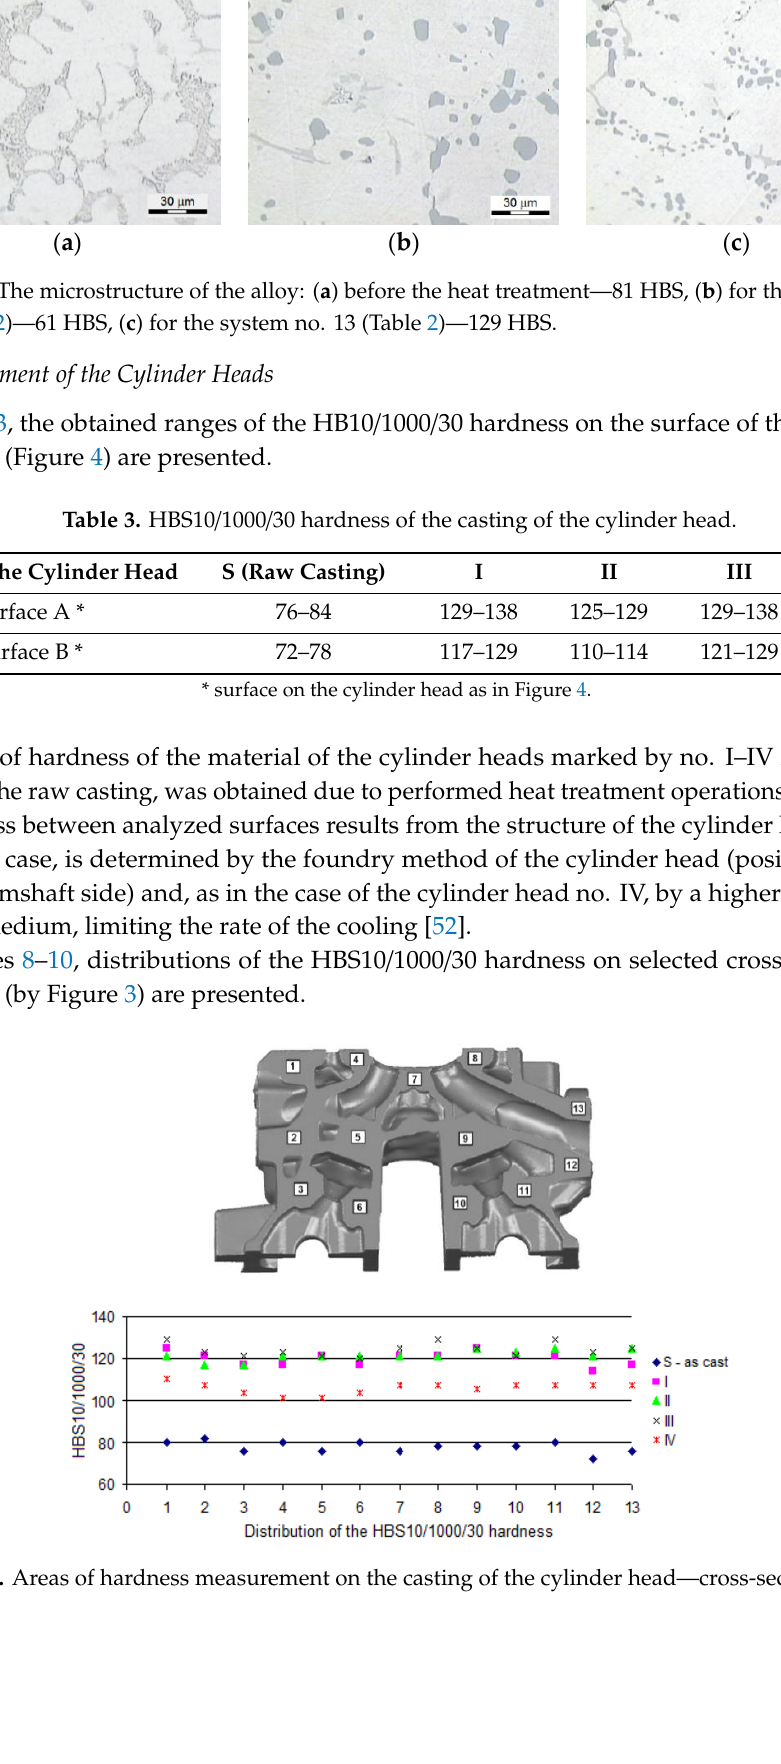
( b ) Figure 6. Influence of the heat treatment parameters on the hardness of the alloy. ( a ) t s and t a , ( b ) τ s and τ a. Taking into account obtained results of the measurements of the molded test pieces, it was ascertained that to obtain a considerable increase in the hardness, the alloy should be solutioned for 1–2 h at a temperature between 500–515 °C and aged for 2–5 h at a temperature below 180 °C (which should result in obtained HBS10/1000/60 hardness at the level of 120–130 (increase at the level of 50%)). Such hardness for the alloy of 319 brands with Mg additive (with a chemical composition similar to the investigated one) was obtained by the authors of the study [32] after solutioning at temperature 495 °C for 8 h and aging at temperature 170 °C for 4–8 h. A similar range of solutioning temperatures (500–520 °C) was recommended by the author of the publication [45], while Han [46] took the temperature of 520 °C as an initial stage of the melting of Al 5 Mg 8 Cu 2 Si 6 phase, dissolution of block-type precipitations of Al 2 Cu and spheroidization of precipitations of Si, with a direct effect on desired mechanical properties. According to Gauthier [47], solutioning temperature above 515 °C results in partial melting of copper phase on boundaries of grains; whereas, in the case of the alloy with 0.5% additive of Mg, Samuel [45] and Ouellet [48] note the beginning of partial melting of Al5Mg8Si6Cu2 and Al 2 Cu phases as early as at temperature 505 °C, resulting in the worsening of mechanical properties of the alloy. Górny [49] recommends the AlSi5Cu3Mg alloy to be solutioned at 510 °C for 5 h and aged for 10 h at temperature 170 °C, while the AlSi5Cu2 alloy at 490–495 °C and aged for 10–15 h at a temperature of 150–160 °C. A completely different approach, namely two-stage solutioning at temperature 495 °C for 2 h and at 515 °C for 4 h,